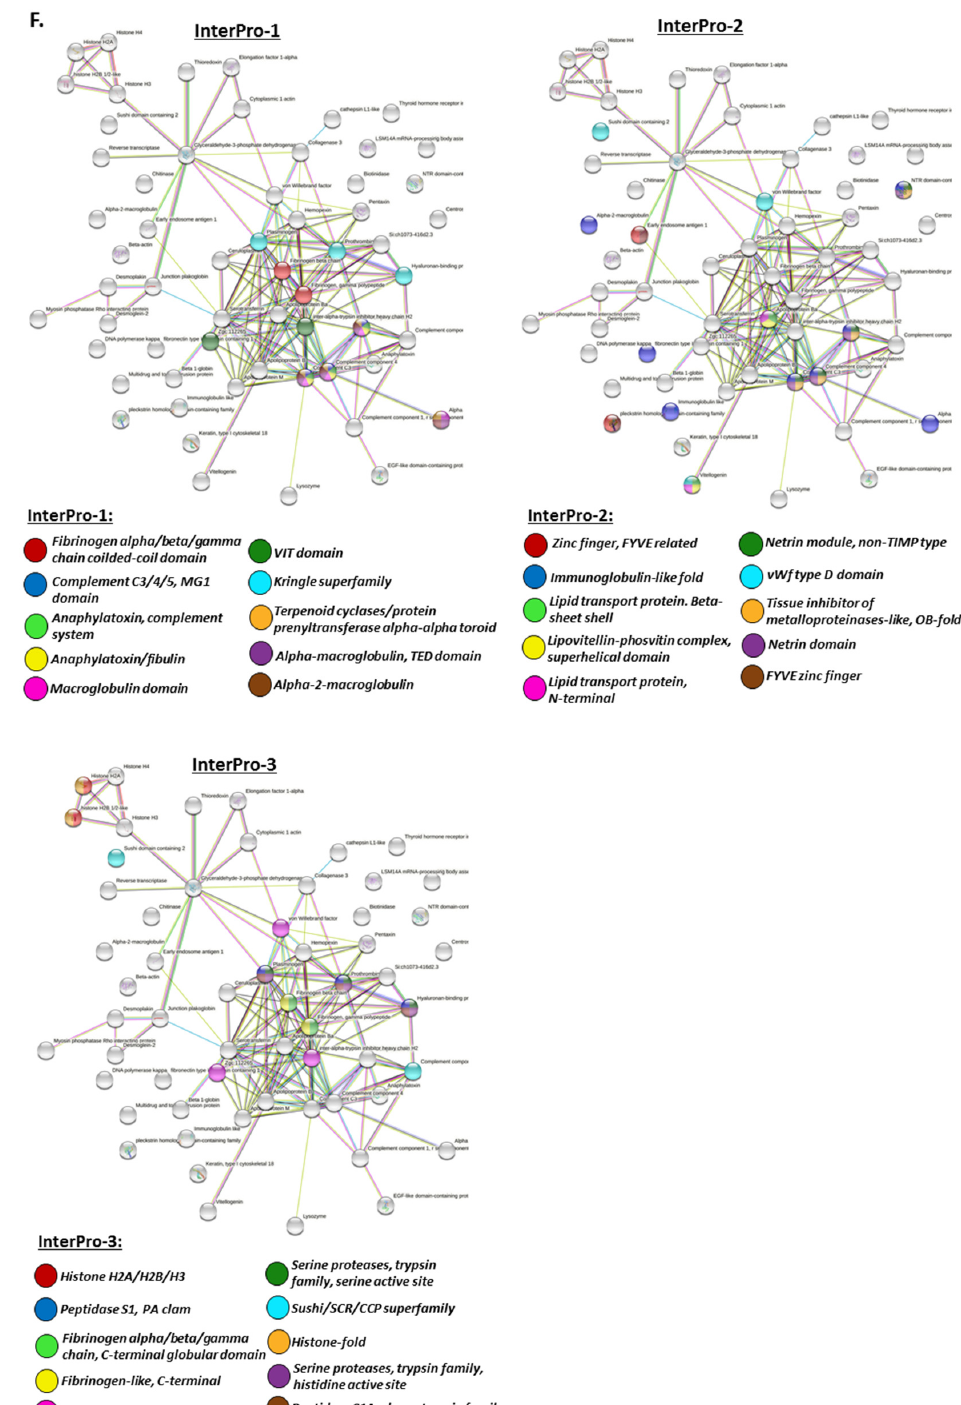
Figure 5. ( A ) Protein interaction networks for total protein cargo in halibut EVs, showing local network clusters. The coloured nodes indicate the different networks, respectively. ( B ) Reactome protein interaction networks for total proteins in halibut EV cargo, showing reactome pathways. Specific reactome pathways are indicated by the coloured nodes, respectively. ( C ) UniProt protein interaction networks for total proteins in halibut EV cargo, showing UniProt keywords. UniProt keywords are indicated by the coloured nodes, respectively. ( D ) PFAM protein interaction networks for total proteins in halibut EV cargo. The specific PFAM protein domains are indicated by the coloured nodes, respectively. ( E ) Protein interaction networks for total proteins in halibut EVs, showing SMART protein domains. The specific SMART protein domains are indicated by the coloured nodes, respectively. ( F ) InterPro protein interaction networks for total proteins in halibut EVs. The specific protein domains and features (InterPro) are indicated by the coloured nodes,